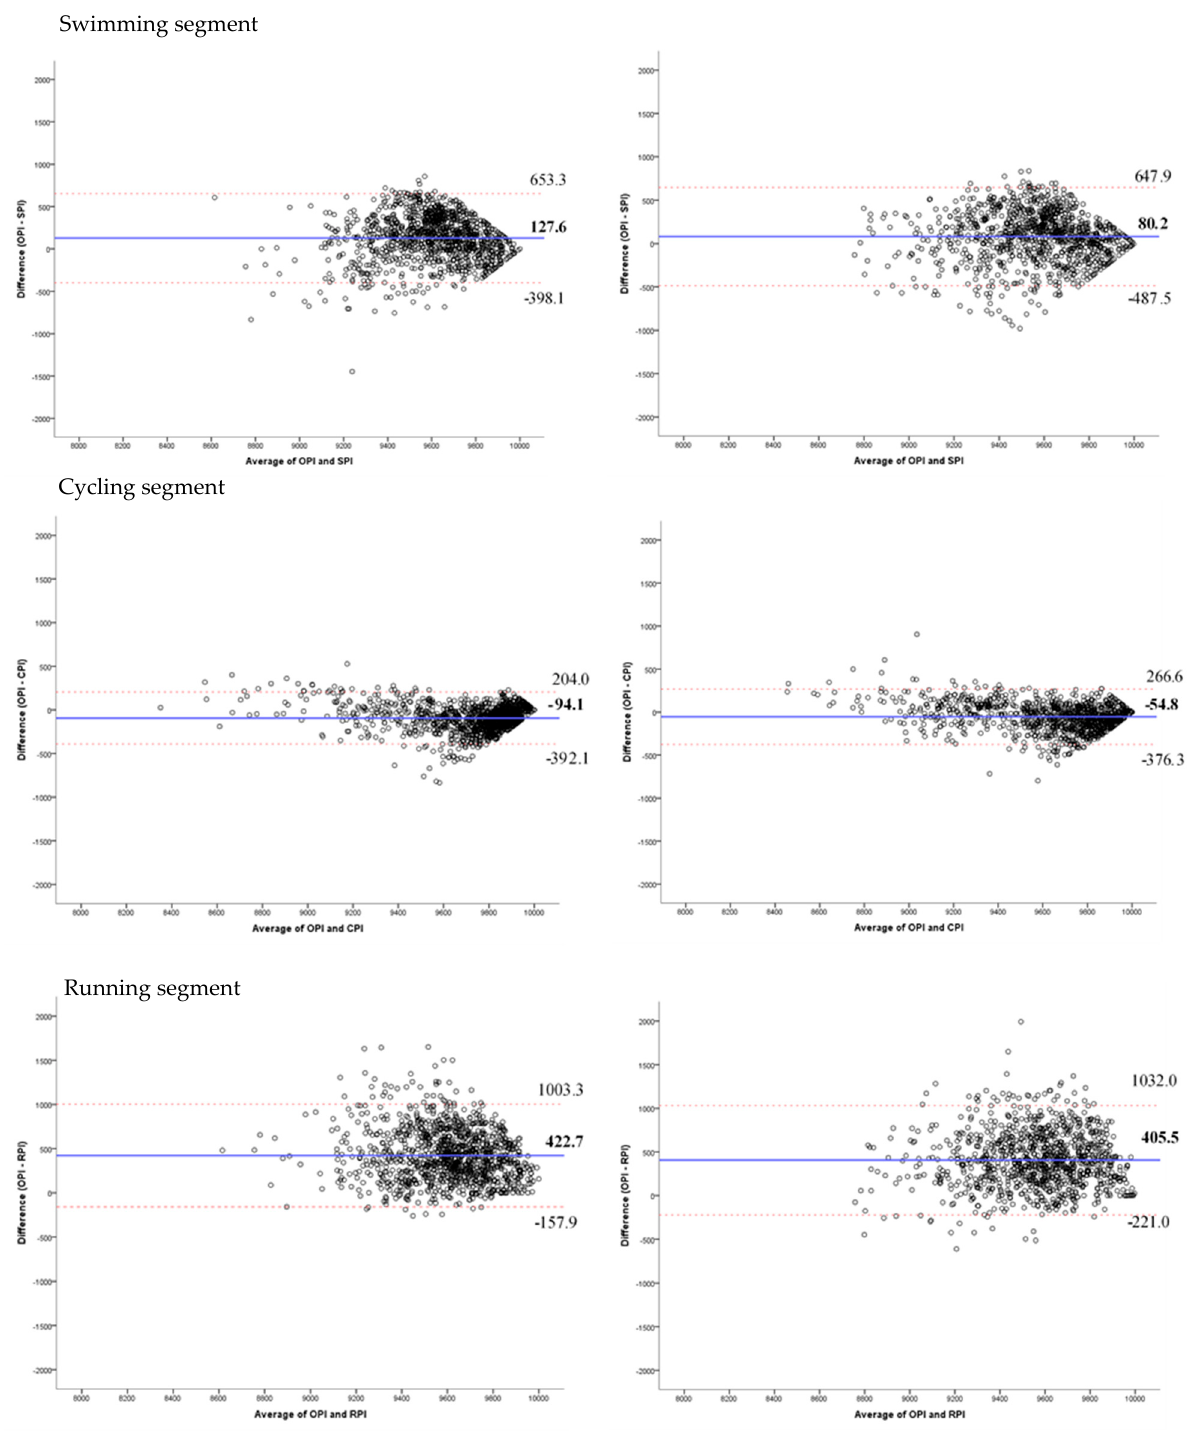
Figure 1. Bland-Altman plots showing differences in performance according to the swimming performance indicator (SPI), cycling performance indicator (CPI), running performance indicator (RPI) and overall performance indicator (OPI). The red lines represent the upper and lower 95% limits of agreement, whereas the blue line represents the bias.